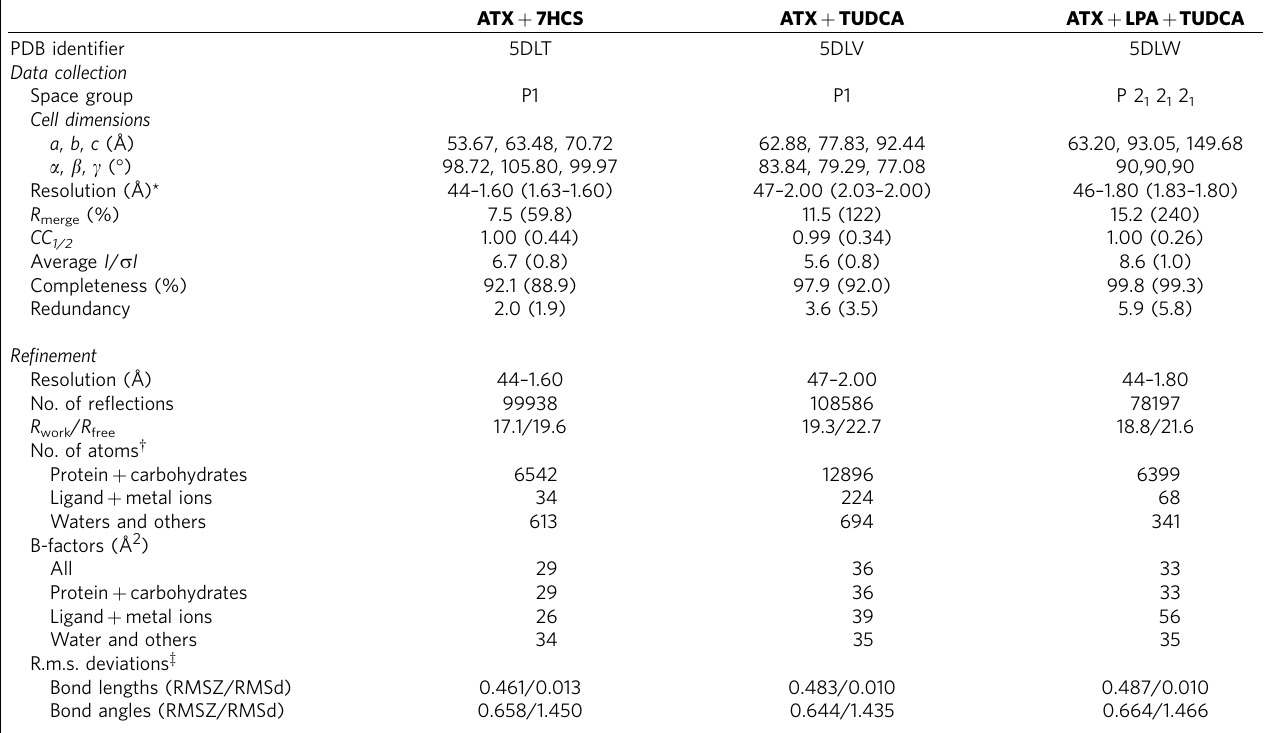
Table 1 | Crystallographic